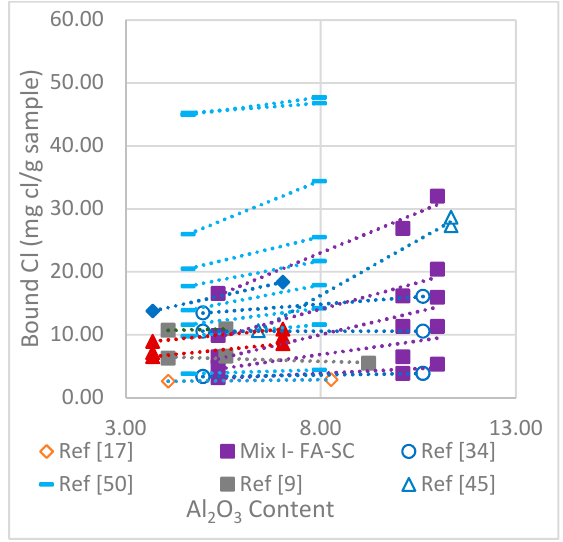
Figure 8. Relationship between Al 2 O 3 content ratio and bound chloride for different chloride con- centrations.